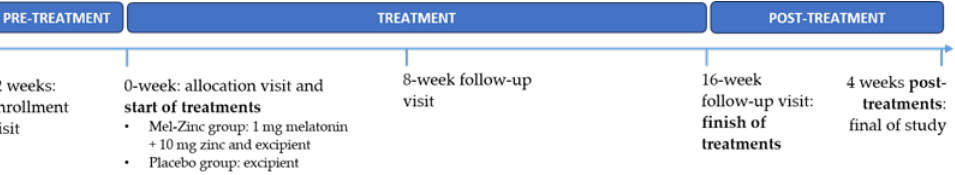
Figure 2. Summarized study schedule at each visit throughout the clinical trial.